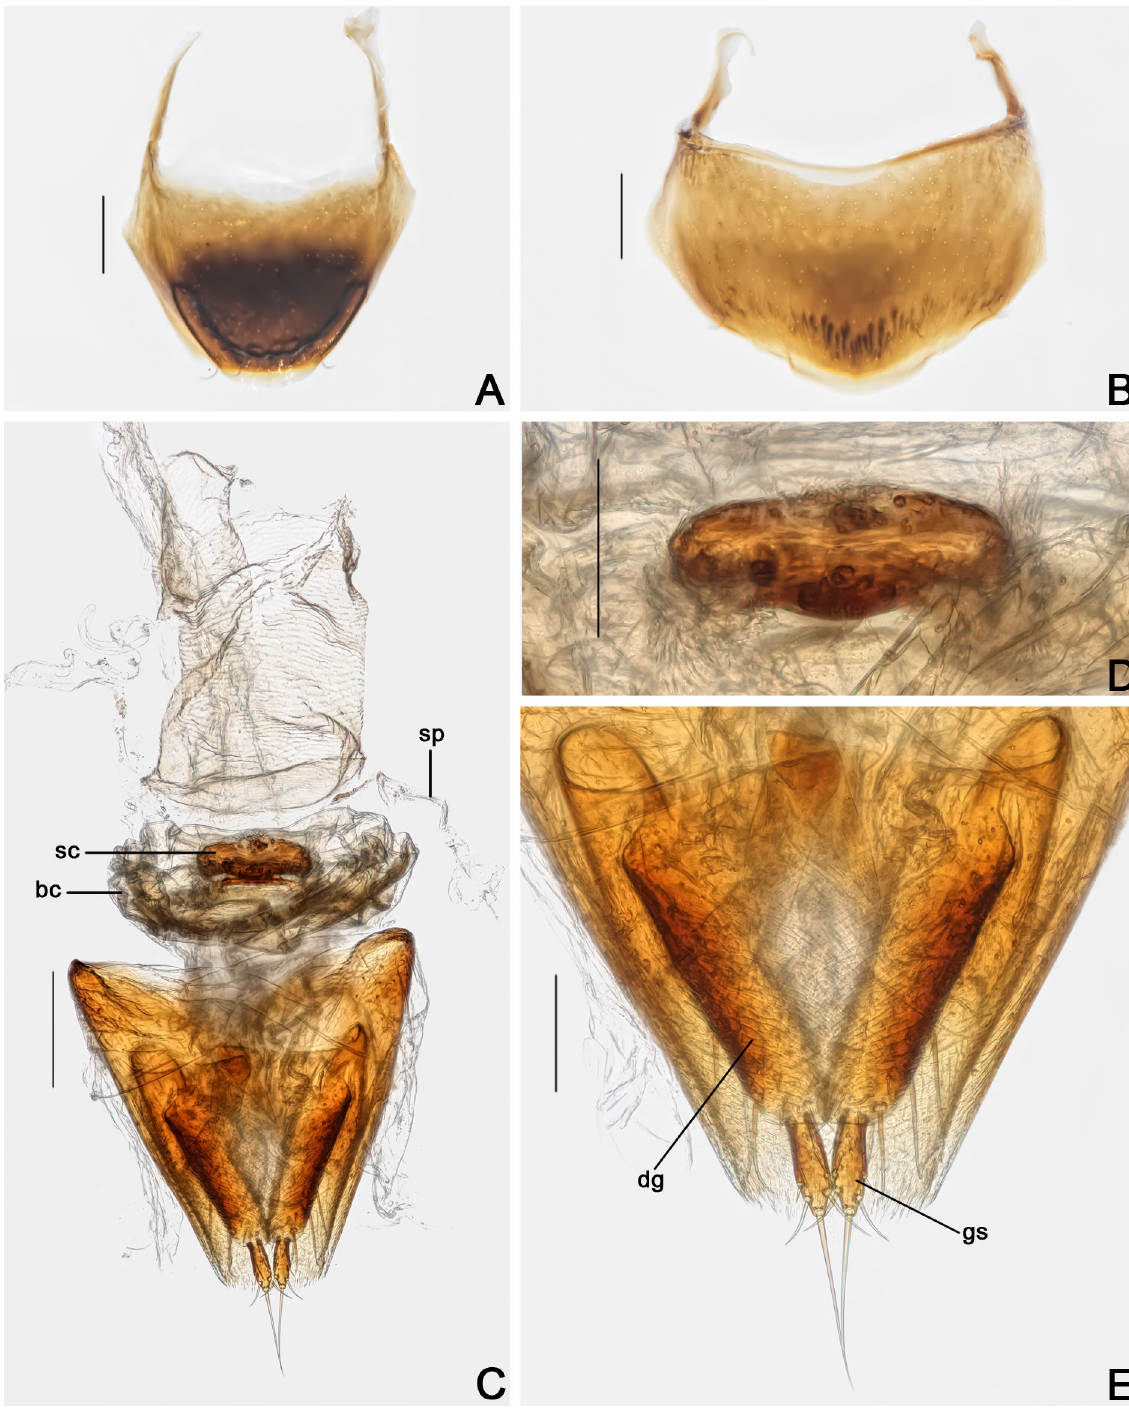
Fig. 13. Cyparium achardi sp. nov., paratype, ♀ (CELC). A . Tergite VIII. B . Sternite VIII. C . Terminalia. D . Sclerite of vaginal plate. E . Ovipositor. Specimen collected at Mata do Paraíso, Viçosa (MG, Brazil). Abbreviations: bc = bursa copulatrix; dg = distal gonocoxites; gs = gonostyli; sc = sclerite; sp = spermatheca. Scale bars: A–C = 0.2 mm; D–E = 0.1